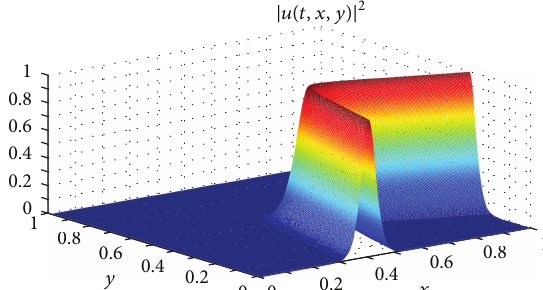
Figure 3: Nonlinear soliton-like structure of the (2+1) -dimensional KGZ equation at time 𝑡 = 0 , given by (33)-(34) and (23) with function 𝑓(𝜂) satisfying